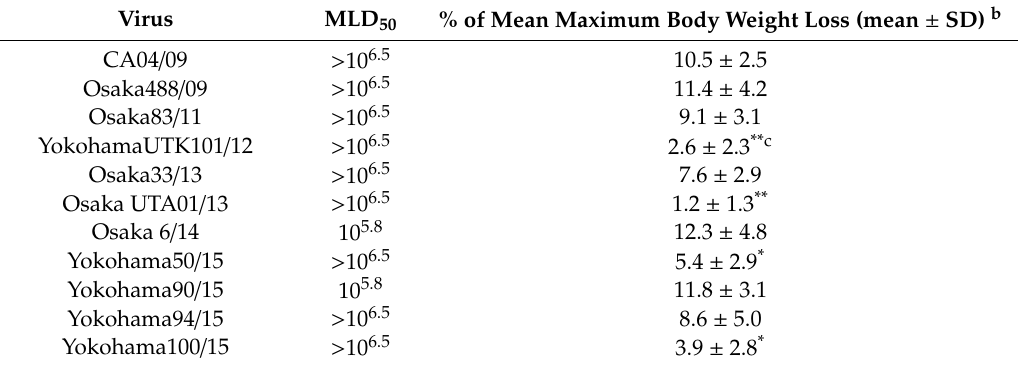
Table 2. Pathogenicity of the Japanese A(H1N1)pdm09 and CA04 / 09 viruses a .